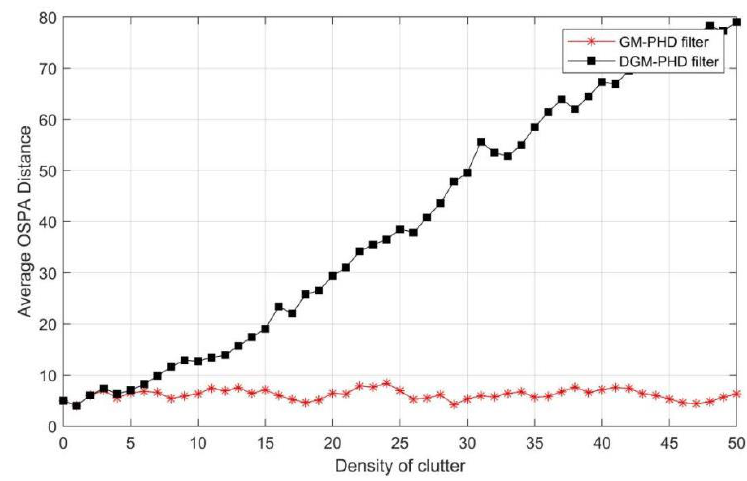
Figure 8. Average OSPA distance of the two filters with the increase of clutter density.